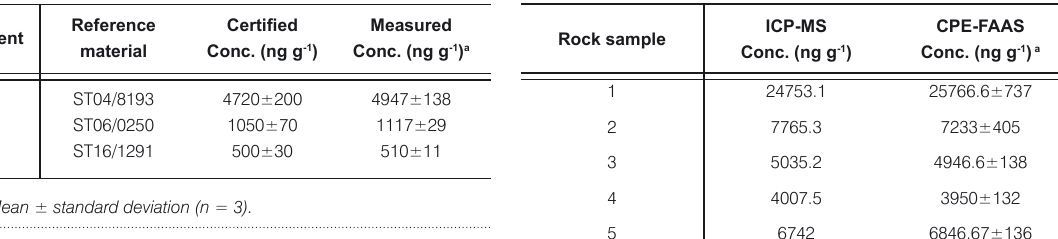
Table 5. Au content of some silicate rock samples determined by the developed procedure using brilliant green as a complexing agent compared with ICP-MS